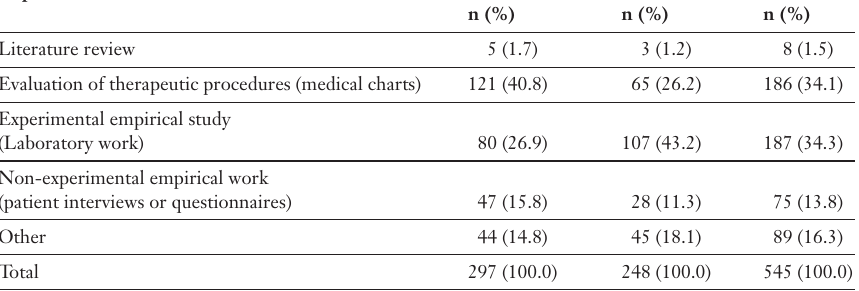
Topic of doctoral thesis (in progress/ already finished) of n = 545